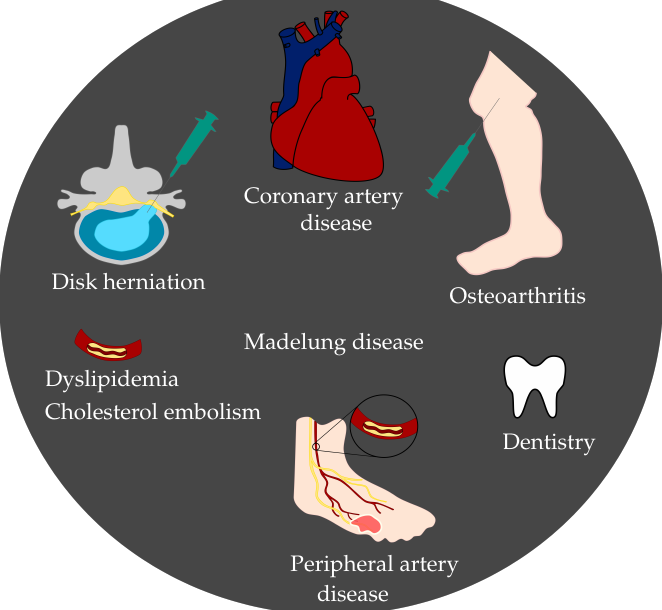
Figure 1. Schematic of possible applications for ozone treatment in healthcare. The applications reach from disk herniation and osteoarthritis, to coronary and peripheral artery disease, madelung disease, dyslipidemia, cholesterol embolism, and